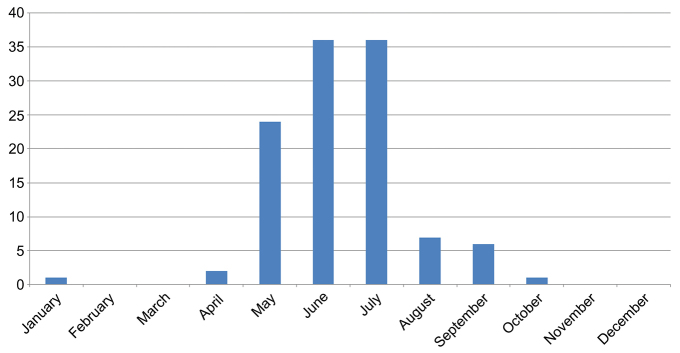
Graph summarising phenology data for 113 male specimens of Idiosoma
sigillatum for which an accurate collection month could be ascertained. The y-axis denotes the number of specimens collected per month. Note the peak of activity in the coolest, wettest months of May–July.